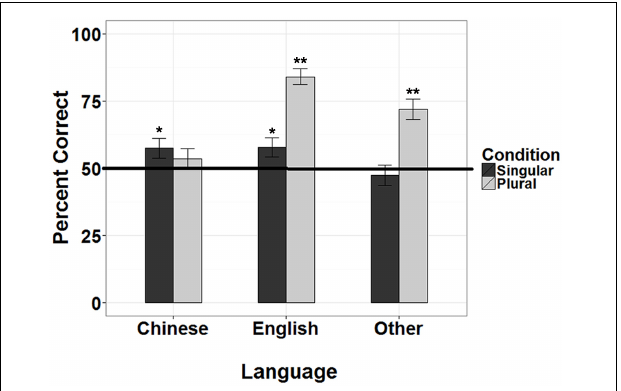
FIGURE 5 | Percent correct on singular and plural items, with performance compared to chance for three L1 groups (English, Chinese, and other languages). ∗ p < 0.05, ∗∗ p < 0.01, error bars indicating standard error of the mean and chance at 50%.